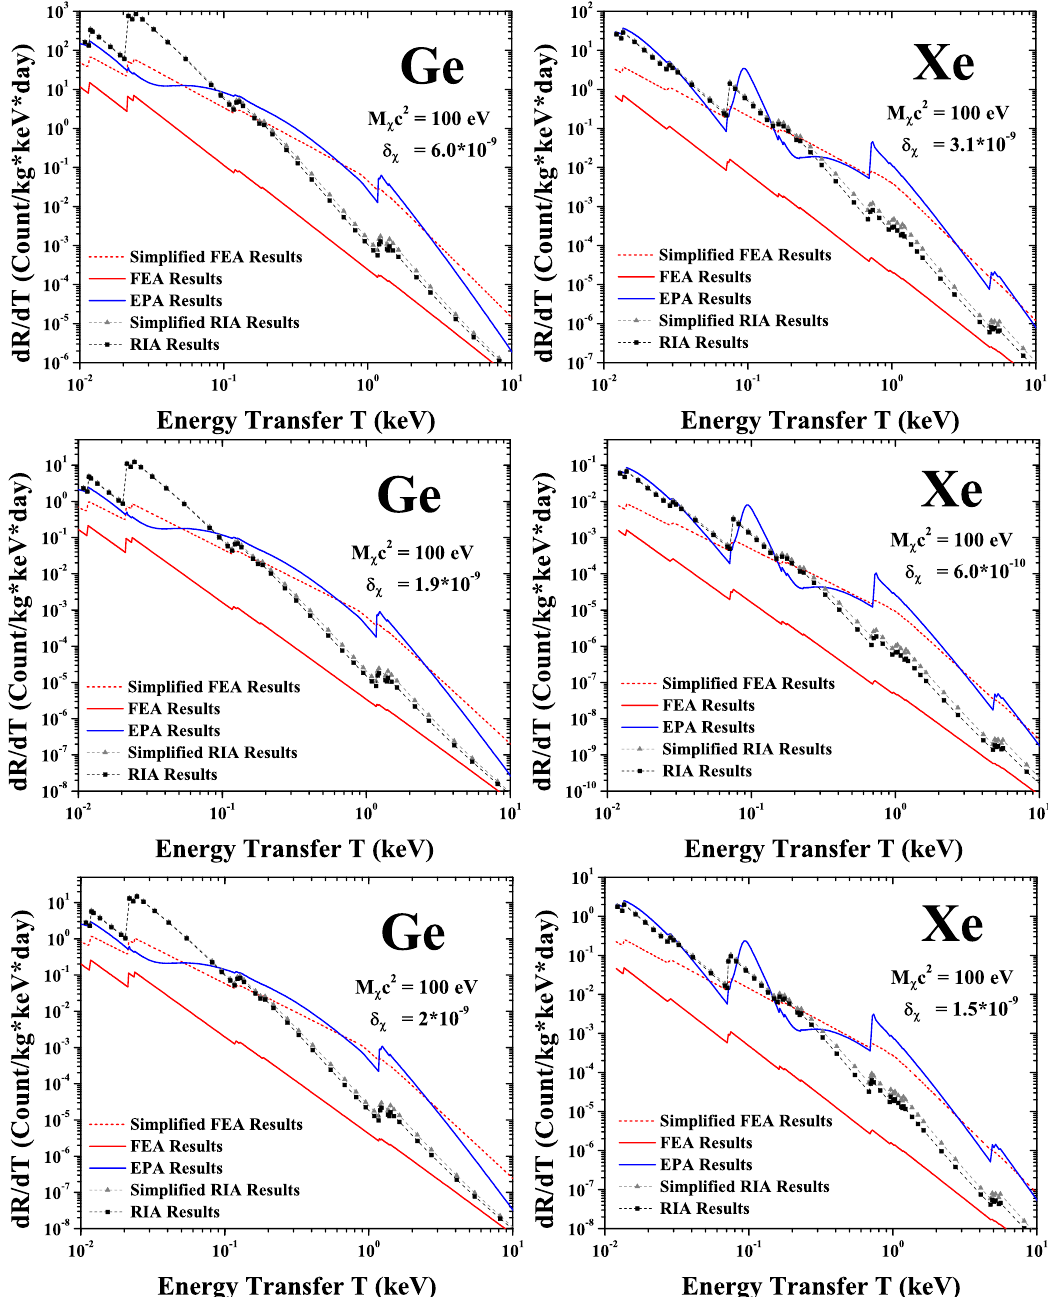
Figure 11 . The differential reaction event rates for the atomic ionization process induced by millicharged particles in HPGe and LXe detectors. The mass of millicharged dark matter particle is set as m is chosen such that the reaction event rates in HPGe 2 = 100 eV, and its millicharge δ χ c χ and LXe detectors match the experimental background levels for next-generation experiments, respectively. In this figure, the horizontal axis represents the energy transfer T , and the vertical axis represents the differential event rate dR/dT in unit of cpkkd. The same as in figure 6 and figure 9, the red solid lines correspond to the FEA results; red dashed lines represent the simplified FEA results; blue lines stand for the EPA results; black squares display the RIA results; gray triangles show the simplified RIA